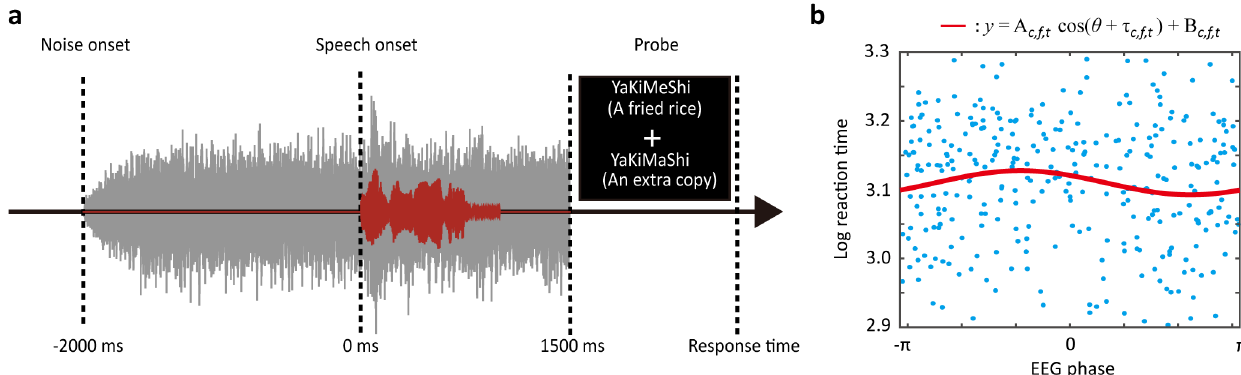
Fig 1. Schematic illustration of the experimental design and phase-utility on behavior (PUB) analysis. (a) Speech recognition task paradigm.Pink noise (shown as a gray wave in the figure) was presentedafter the trial interval, and a speech sound (shown as a red wave) was presented2 sec after the onset of the noise. A probe was presentedafter the sound stimulus was presented. (b) An exampleof the relationship betweenthe EEG phase and reactiontime. The logarithmicreactiontime was plotted as a function of the instantaneous EEG phasefor each trial (blue plot). The red line was estimated by the least squaremethod. The amplitudeof the cos-curve was definedas the PUB index.